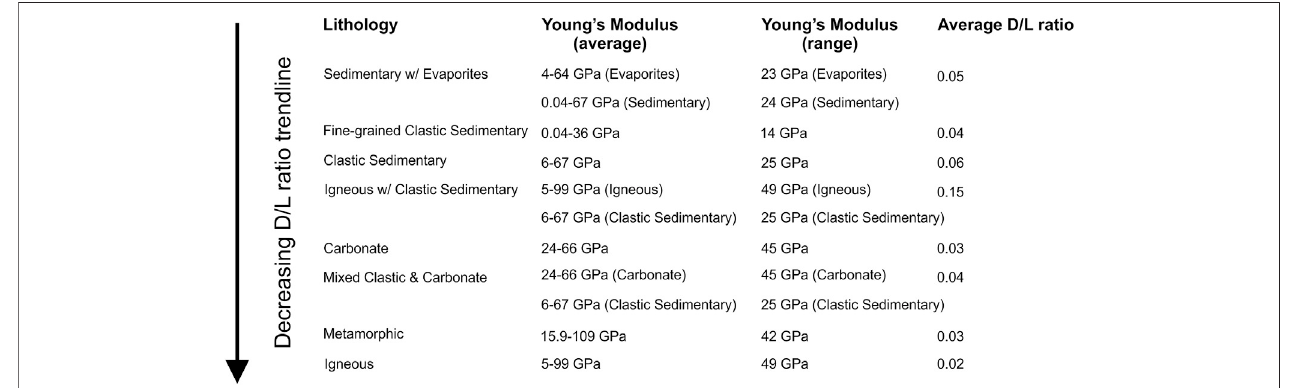
FIGURE 12 | Figure showing how the Young ’ s Modulus of different lithologies relates to D/L. The range of Young ’ s Modulus, average Young ’ s modulus, and average D/L for fault with host rocks of each lithology is shown. Generally, as Young ’ s Modulus increases, D/L decreases. Our Young ’ s Modulus data and sources can be accessed here: https:// fi gshare.com/articles/dataset/Young_s_Modulus/17087342.